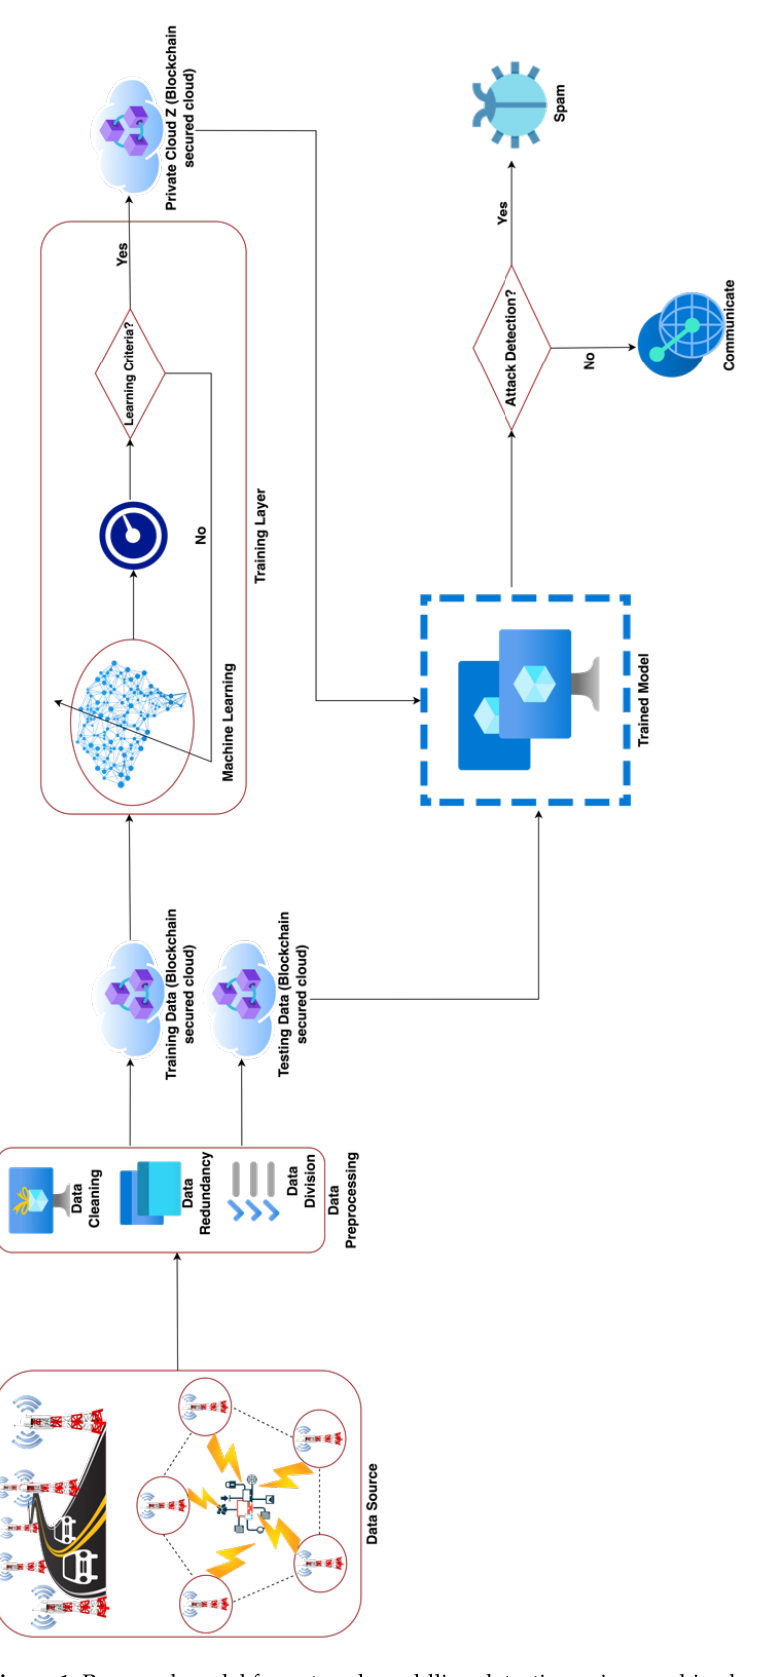
Figure 1. Proposed model for network meddling detection using machine learning entangled with blockchain technology.